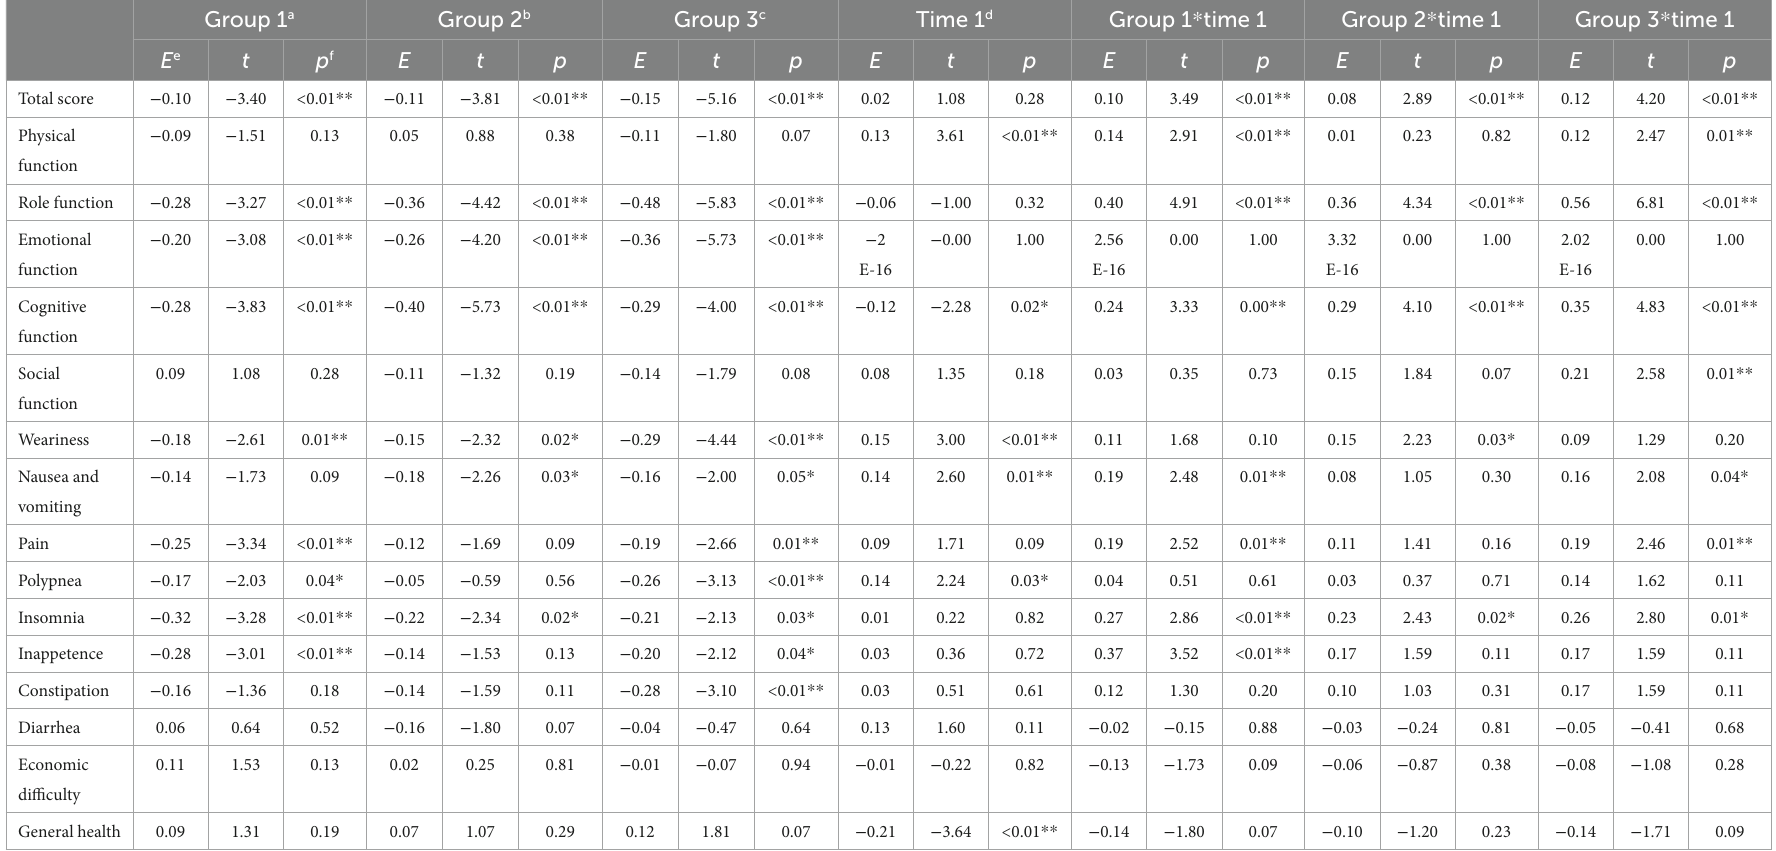
TABLE 4 Fixed effects of quality of life results ( n =